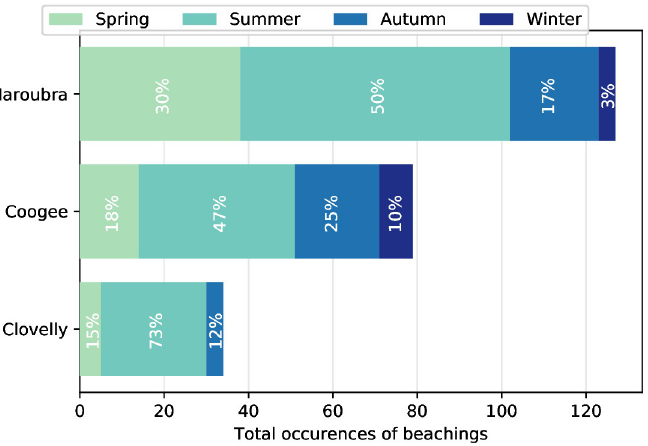
Fig 4. Bar plot for each beach, showing the occurrence of observed beaching events for each season (see legend) from the 2016–2020 daily lifeguard data. The total occurrences indicate the number of days over the four years and the percentages for each season are relative to the total numbers of occurrences per beach (e.g. in Maroubra 50% of the beachings occurred in summer). Winter months are not seen for Clovelly as there is no data.